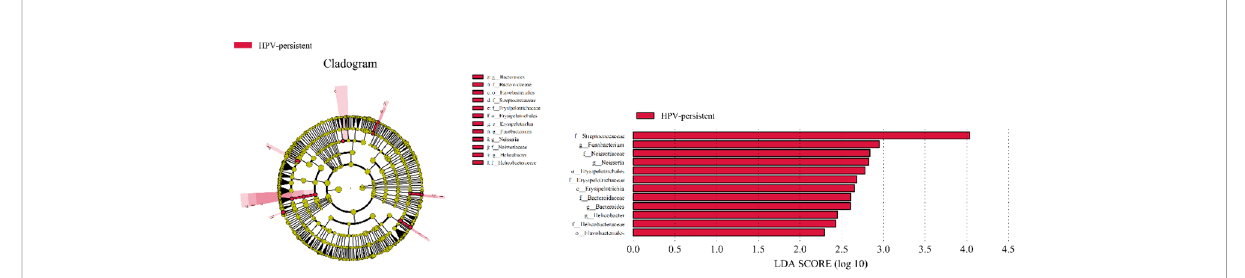
FIGURE 13 LEfSe analysis comparing microbial variations at the genus level in infected and healthy individuals. LEfSe cladogram representing differentially abundant taxa ( p < 0.05). LDA scores as calculated by LEfSe of taxa are differentially abundant among groups. Only taxa with LDA scores of >2 are presented.